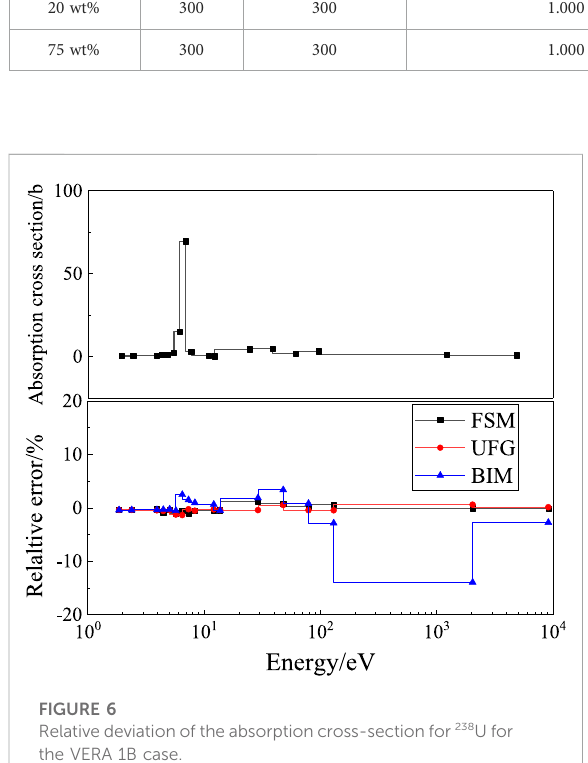
FIGURE 6 Relative deviation of theabsorption cross-section for 238 U for the VERA 1B